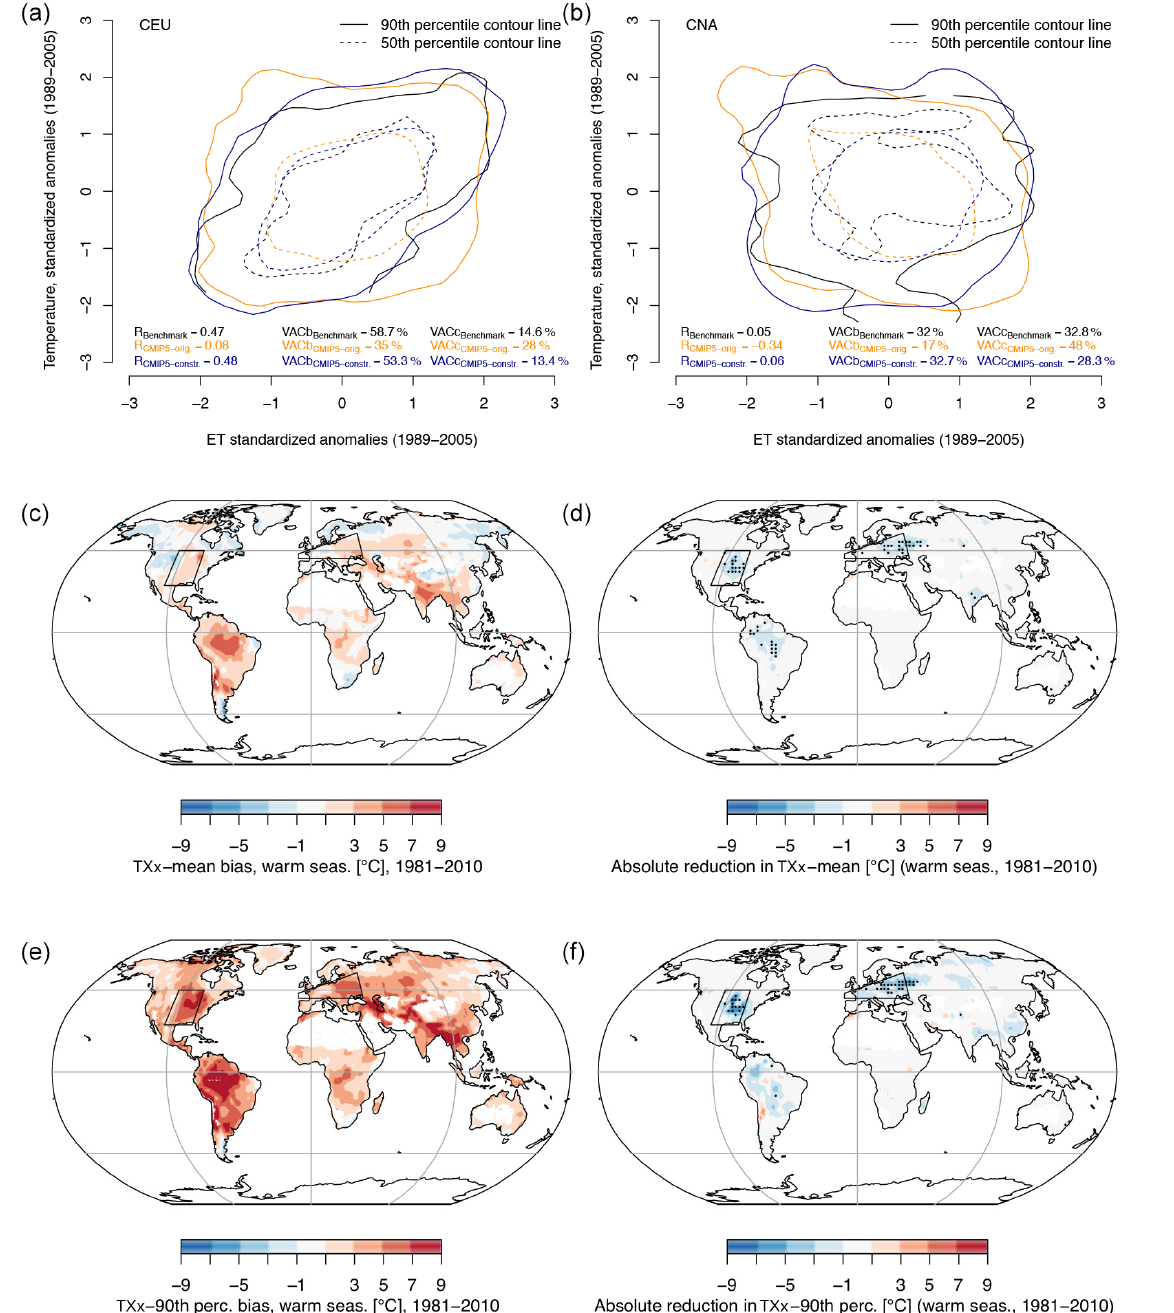
Figure 4. (a, b) Contour lines of bivariate kernel density estimates of T –ET relationship in the benchmarking datasets and the original and constraint CMIP5 ensemble for (a) central Europe and (b) central North America (1989–2005, area average). (c, e) Biases in warm season (c) TXx mean and (e) 90th percentile of TXx in the original CMIP5 ensemble and (d, f) reduction in (d) TXx mean and (f) 90th percentile TXx through the application of the land-coupling constraint. Regions with a significant reduction in (d) TXx mean and (f) the across-model average in the 90th percentile of TXx according to a permutation significance test are